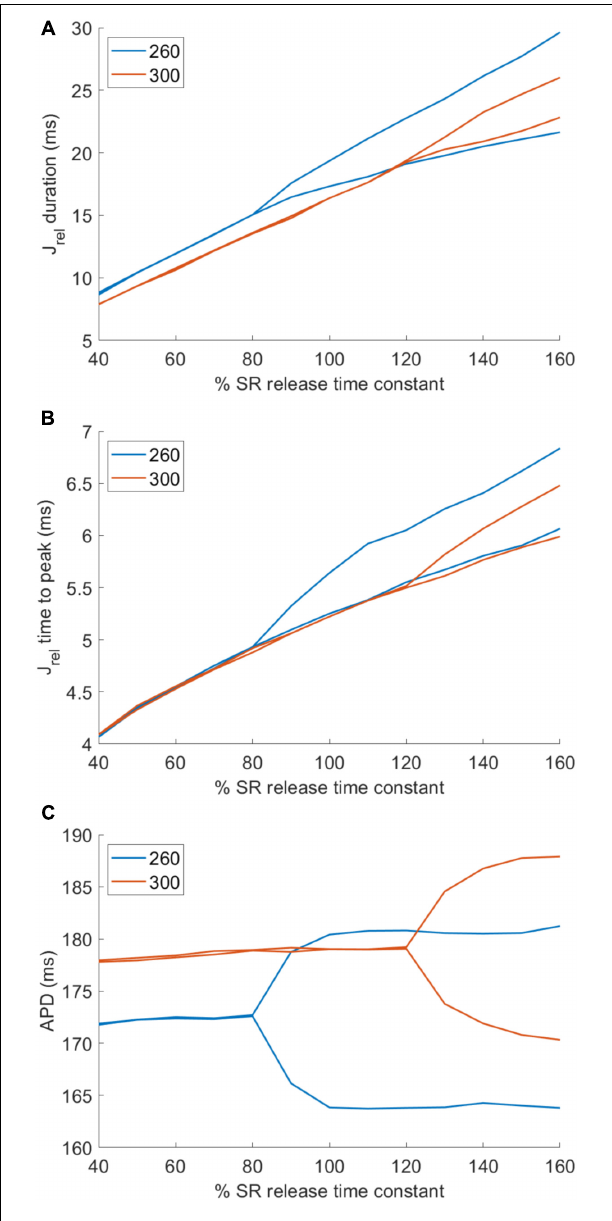
FIGURE 6 | Effect of altering SR release dynamics on alternans at 260 and 300 ms bcl in the HeRd model. Changes in time to peak release (A) and duration of release at 90% release recovery (B) with scaling of SR release time constant at two pacing rates. The bifurcations correspond to alternans of the respective feature, concurrent with APD alternans (C)